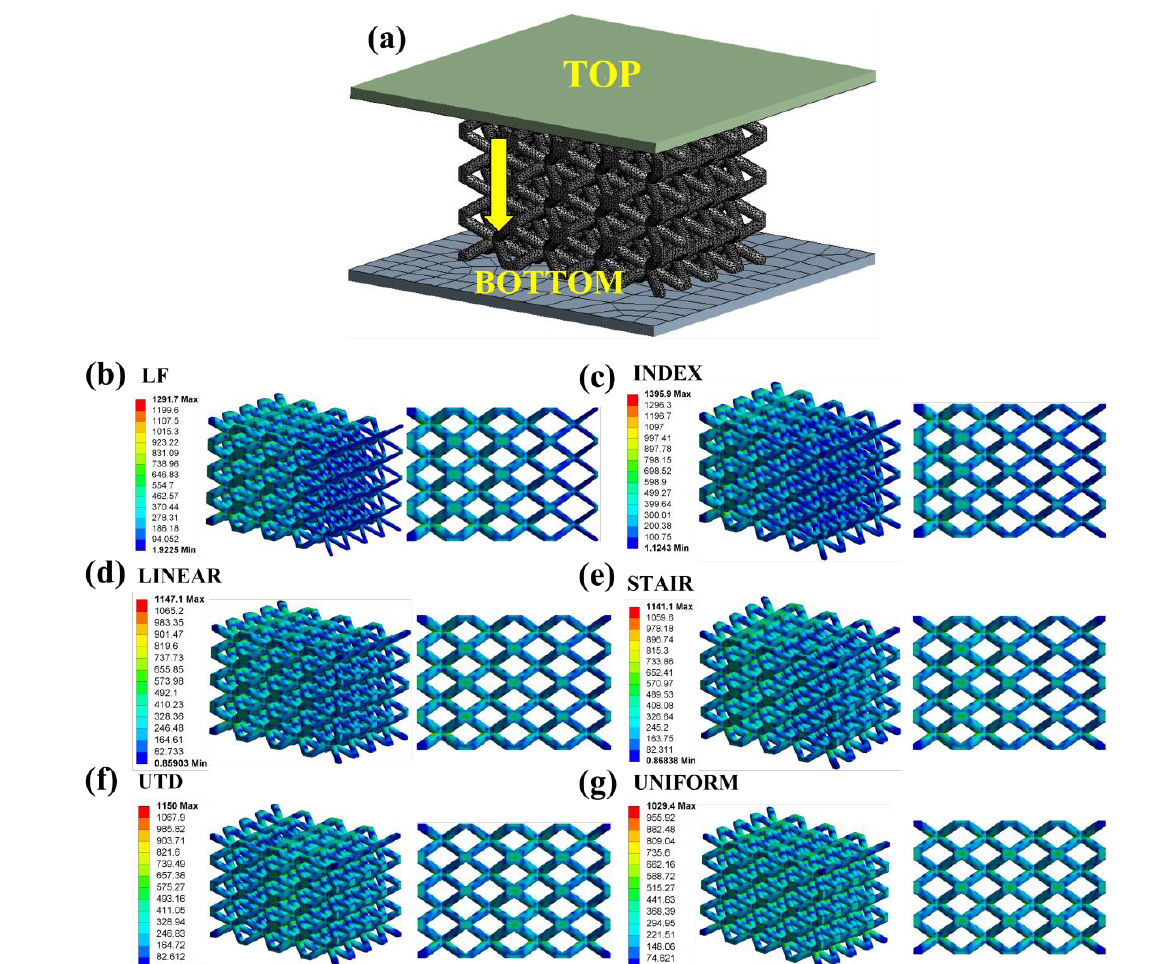
Figure 9. Pre-processing ( a ) and post-processing ( b – g ) of finite element analysis.